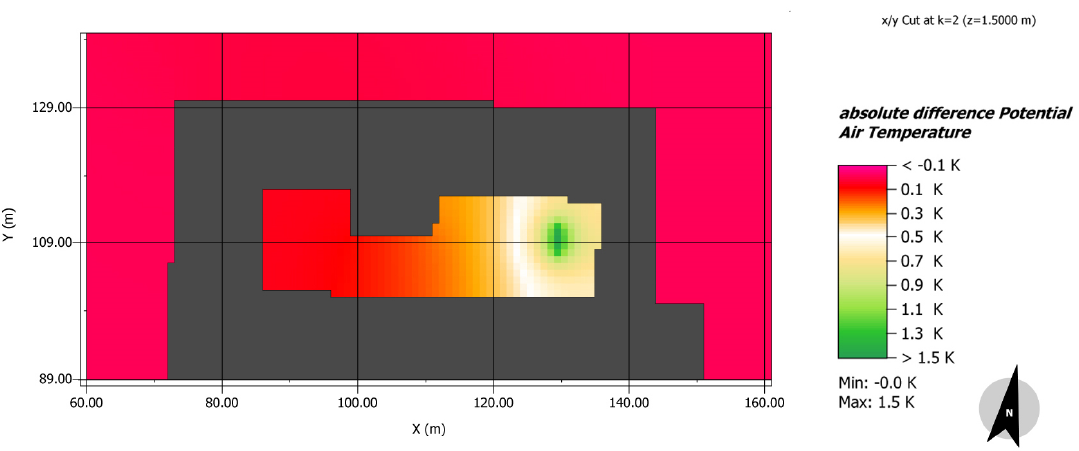
Figure 5. The difference of air temperature between absolute current state and the reference water curtain scenario. Figure by authors.